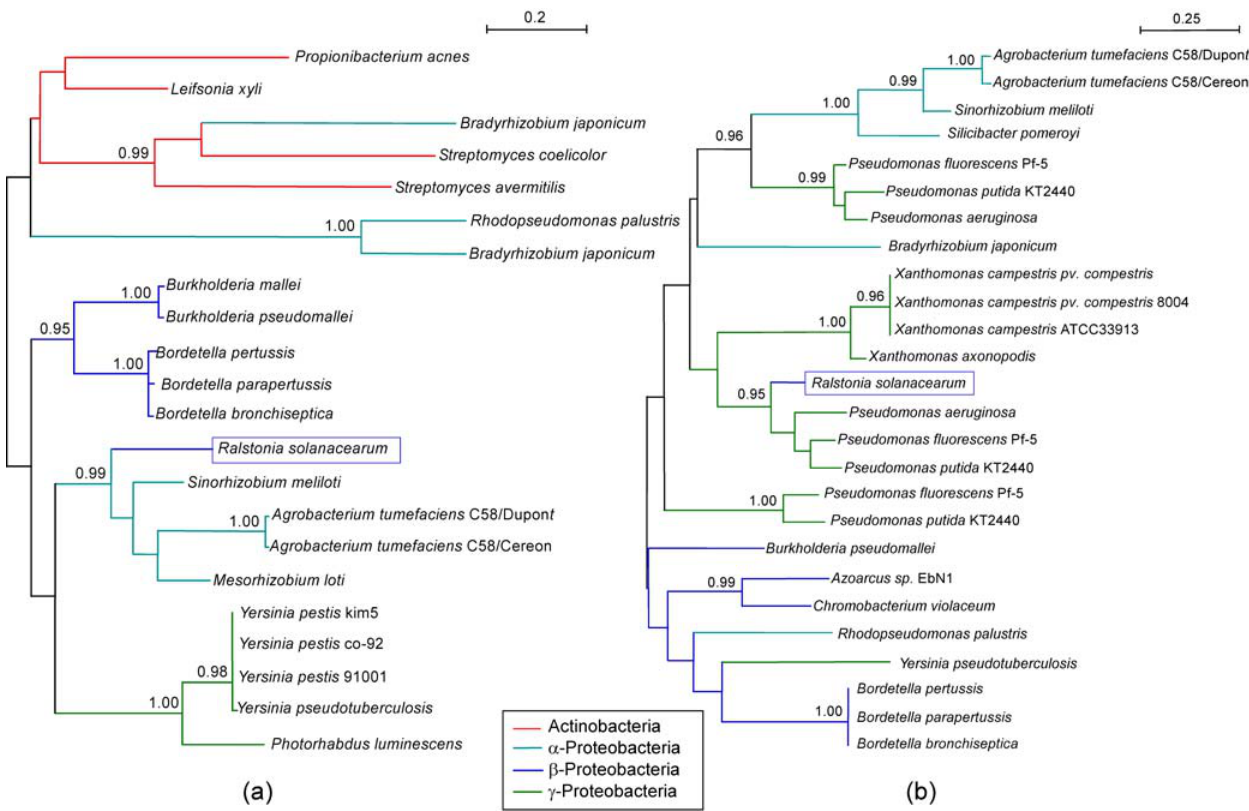
Figure 2. Two examples of HGT detected on the megaplasmid (a) and on the chromosome (b) through a phylogenetic approach. The two trees have been built respectively with the sequences from the HOGENOM families HBG007143, corresponding to the Proline imminopeptidase (a), and HBG225336, corresponding to the transcriptional regulator of Acetoin catabolism (b). The value for the Shimodaira-Hasagawa likelihood ratio test is given for the internal branches (only when P $ 0.95). In both cases, the sequence from R. solanacearum is not clustered with the other b - proteobacterial sequences, this with a significant value for the clustering test.